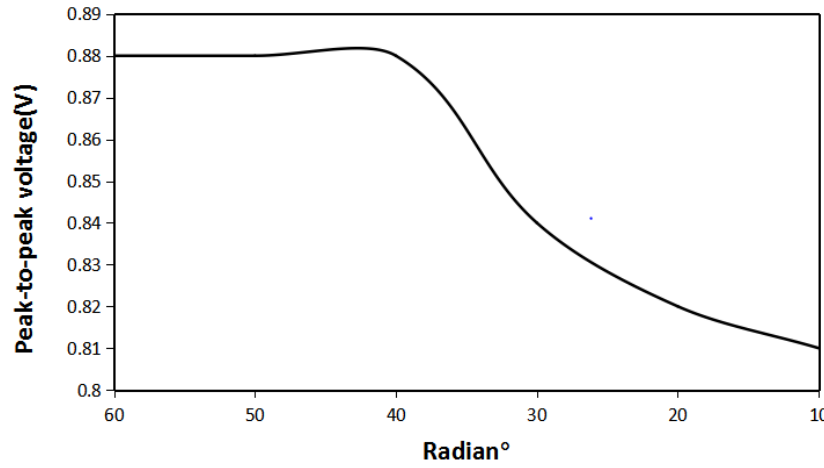
Figure 15. The relationship between the radian of iron sheet and the maximum voltage.